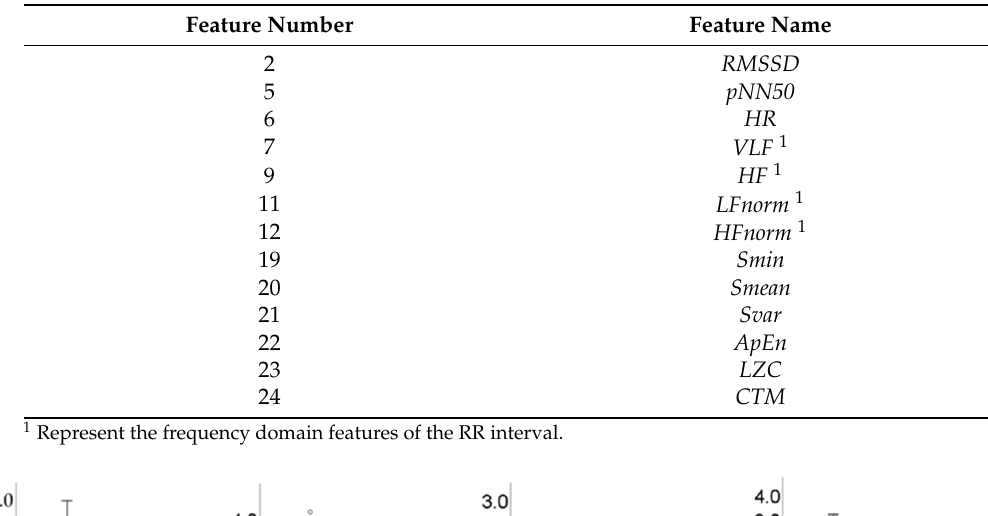
Table 3. Feature number corresponding to the feature name.